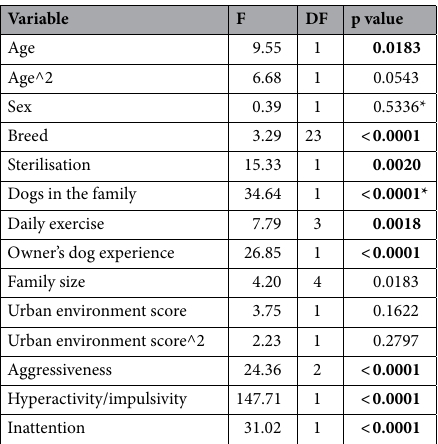
Table 1. Associations of the demographic, environmental, and behavioural variables with repetitive behaviour in the logistic regression analysis. P-values, except a priori contrasts, are controlled for false discovery rate. Variables for which a priori contrasts were set and which p-values are not false discovery controlled are denoted with *. Significant effects are indicated in bold (p-value < 0.05). N =